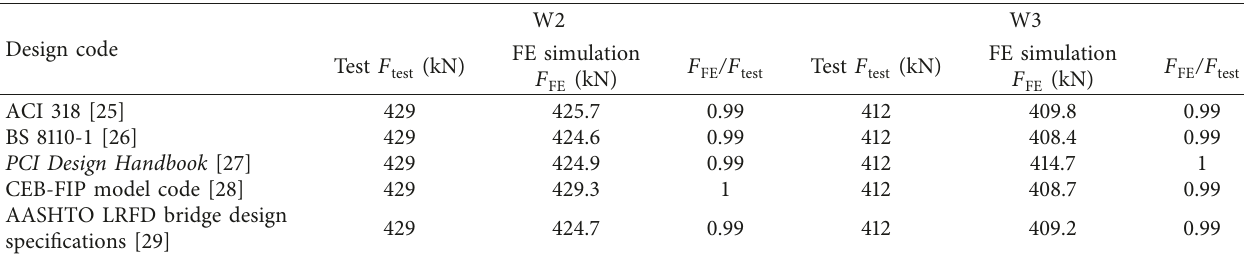
Figure 14: Comparison of simulated and experimental response: (a) W2 and (b) W3. Table 4: Comparison of ultimate bearing capacity between experiments and FE simulation using different bond stress values based on different design